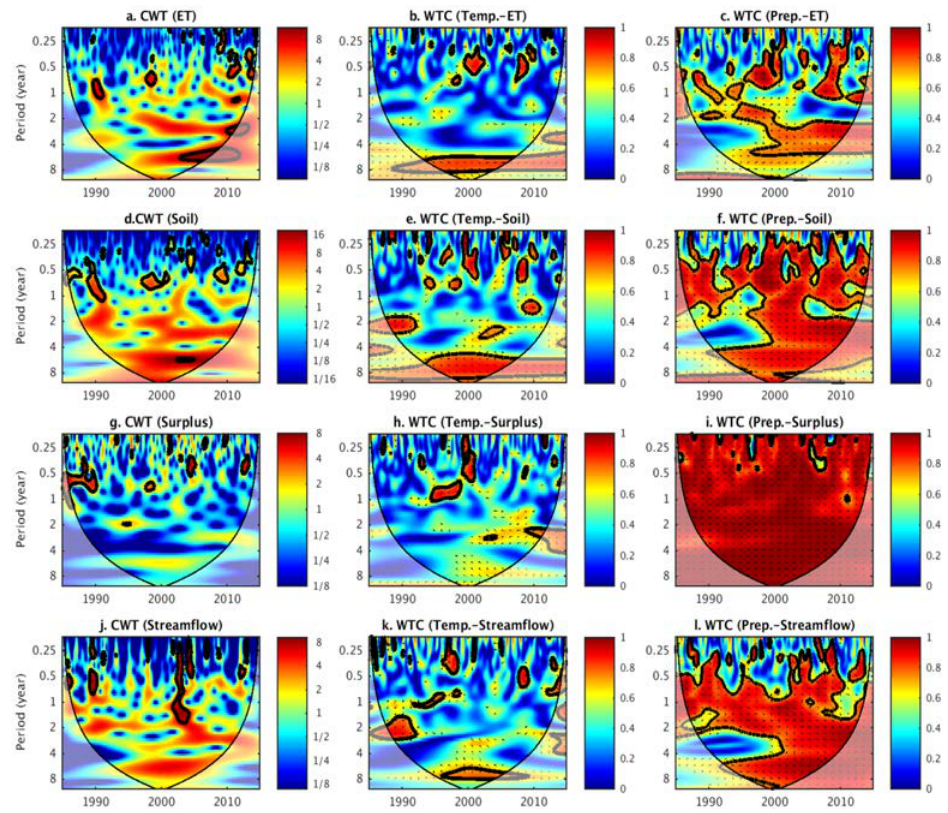
Figure 10. Continuous wavelet transform (CWT) of monthly anomaly of model-simulated ( a ) evapotranspiration, ( d ) soil moisture, ( g ) water surplus, and ( j ) streamflow and squared wavelet coherence (WTC) between temperature anomaly and the anomaly of model-simulated ( b ) evapotranspiration, ( e ) soil moisture, ( h ) water surplus, and ( k ) streamflow; between precipitation anomaly and anomaly model-simulated ( c ) evapotranspiration, ( f ) soil moisture, ( i ) water surplus, and ( l ) streamflow. The horizontal axis is the 30 years of records beginning January 1985. Thicker lines bounding areas of red indicate significant coherence at the 95% level against red noise. Arrows indicate the phase difference between the wavelet spectra (right arrows indicate series are in phase, left arrows indicate series are completely out of phase). Thin solid lines indicate the cone of influence outside of which paler colors indicate the influence of edge effects and must be viewed with